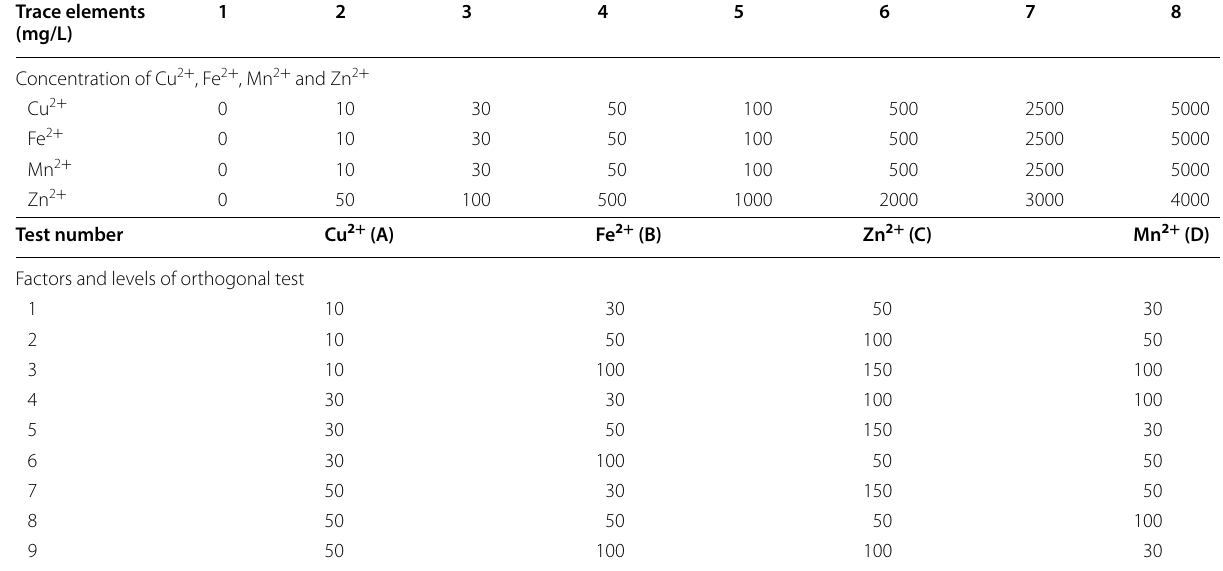
Table 1 Screening of the concentrations of four single trace elements and orthogonal table of trace elements concentration